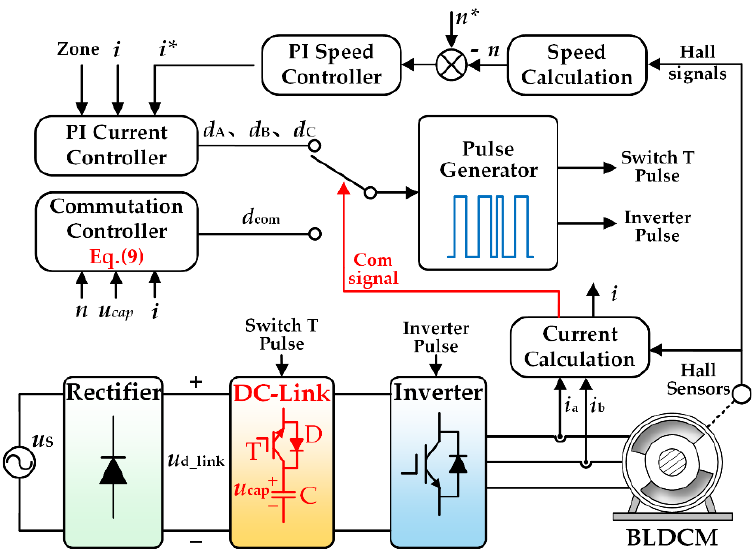
Figure 8. A system control structure diagram of the strategy is proposed.